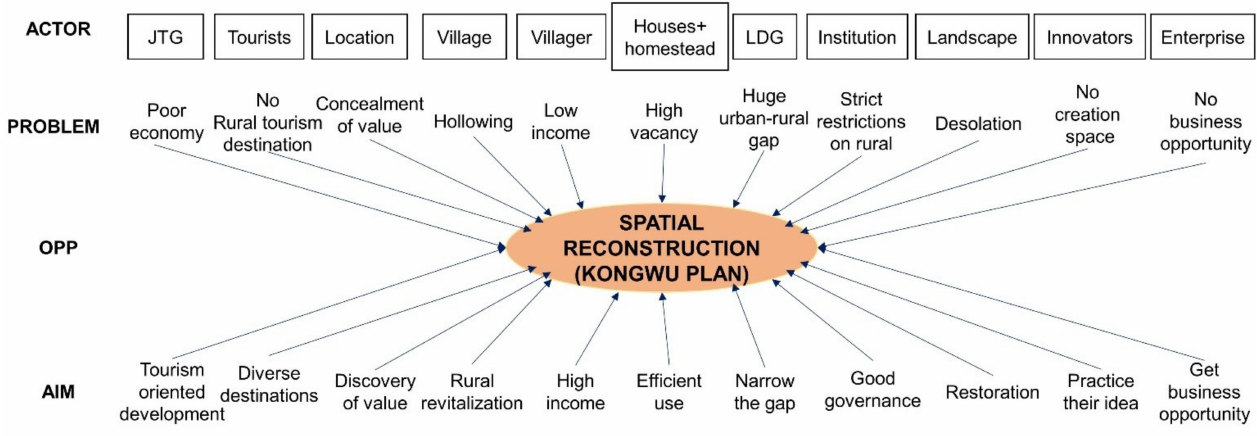
Figure 4. Actors and the obligatory passage point (OPP) of space reconstruction in